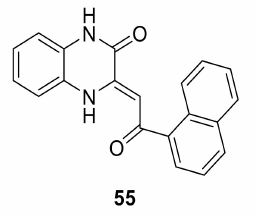
Figure 23. Chemical structure of compound 55